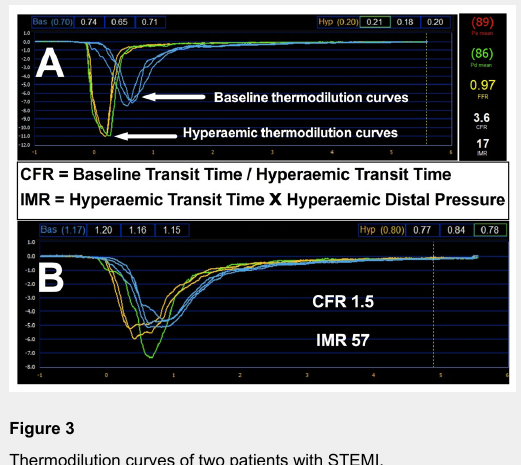
Thermodilution curves of two patients with STEMI. Coronary microcirculation is preserved in patient A, while it is moderately impaired in patient B. Coronary Flow Reserve (CFR) is calculated as a ratio of mean baseline transit time (blue) and mean hyperaemic transit time (yellow). The index of microcirculatory resistance (IMR) is calculated as hyperaemic transit time x mean distal coronary pressure during